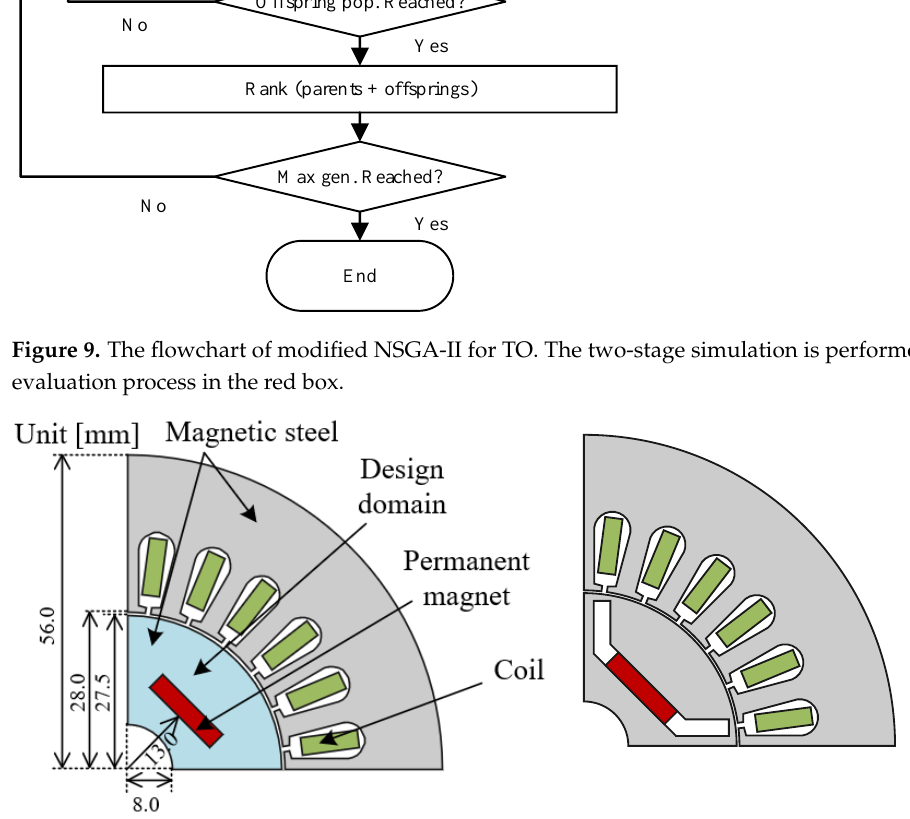
Figure 9. The flowchart of modified NSGA-II for TO. The two-stage simulation is performed in the evaluation process in the red box.